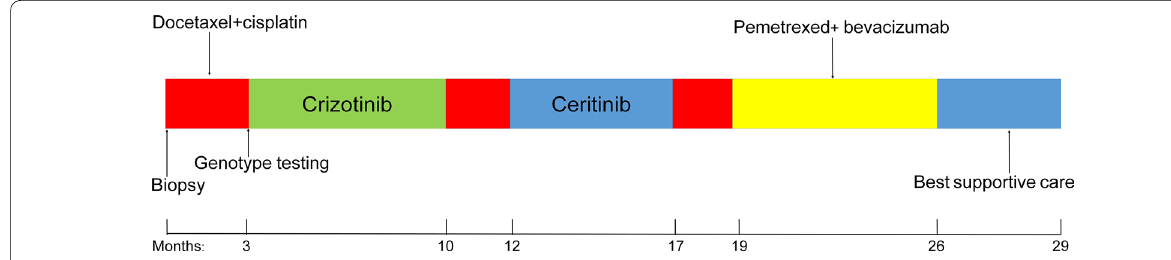
Fig. 4 Re-evaluation and genotype testing of the left lung neoplasm. a Hematoxylin and eosin staining demonstrating adenocarcinoma (magni- fication 200). b Immunohistochemical staining for the ALK protein revealing strong granular cytoplasmic expression in the lung adenocarcinoma × specimen (magnification 200). c EML4-ALK rearrangement positive confirmed by fluorescence in situ hybridization (magnification ×